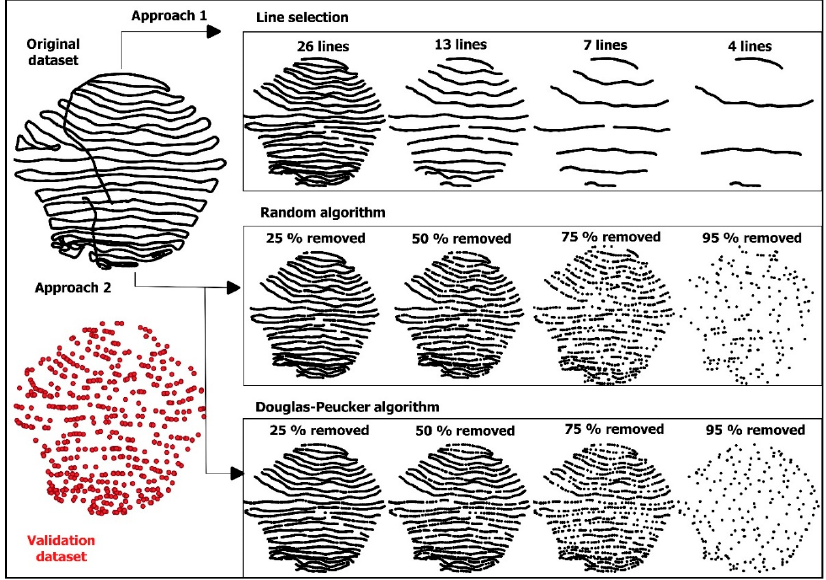
ff erent sampling designs for the selection of simulation Figure 3. Workflow for different sampling designs for the selection of simulation datasets. Figure 3. Workflow for di